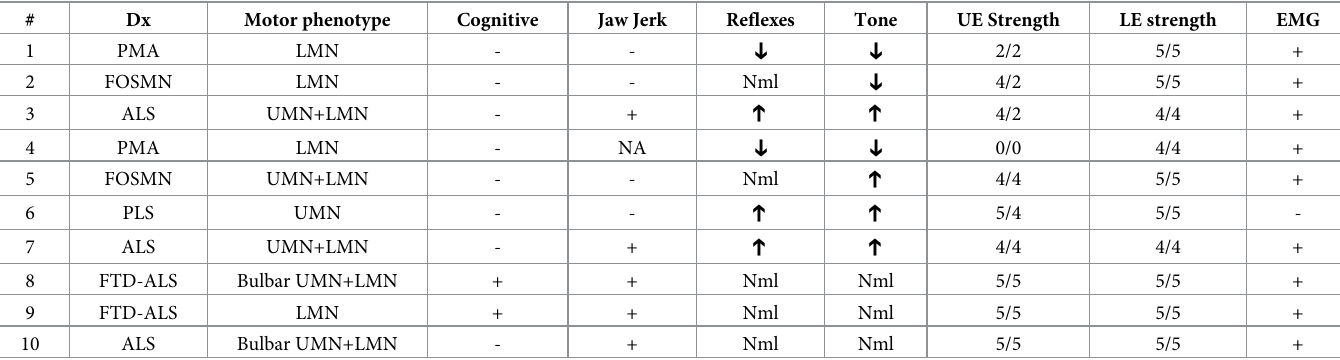
Table 3. Cognitive and motor findings of patients with motor neuron